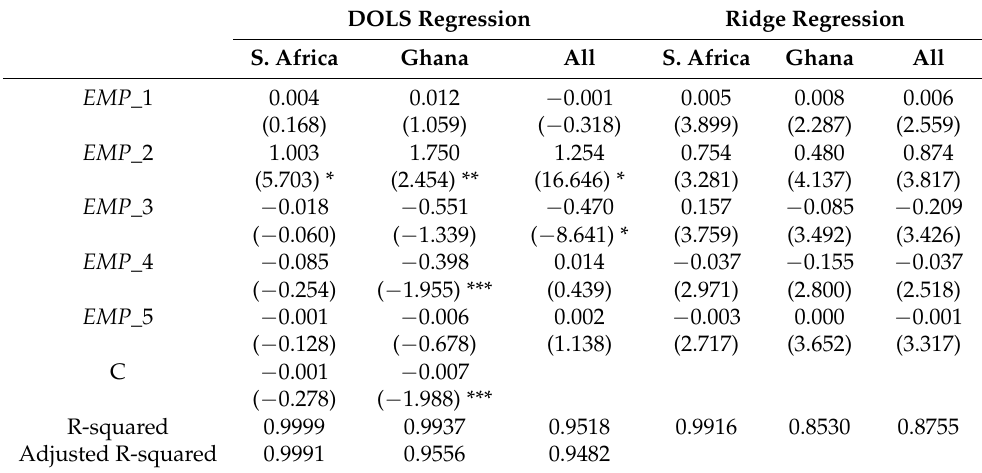
Table 2. The best EMP index for South Africa and